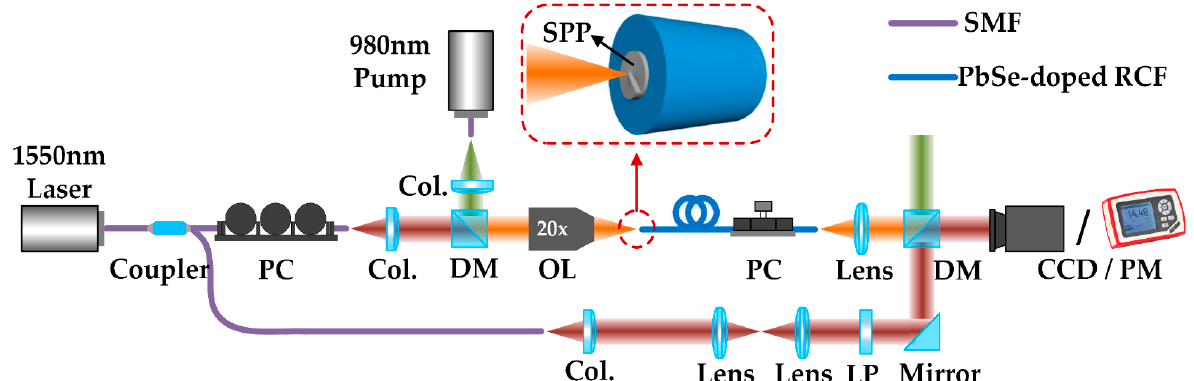
Figure 5. Schematic of the experimental setup for the OAM amplifier. PC: polarization controller; Col.: collimator; SMF: single-mode fiber; PbSe-doped RCF: PbSe-doped ring-core fiber; DM: dichroic mirror; OL: objective lens; SPP: spiral phase plate; LP: linear polarizer; PM: power meter. The intensity distributions of the OAM modes ( | l | = 1, 2, 3, 4) measured by the CCD are shown in Figure 6, along with the spiral interference fringes.